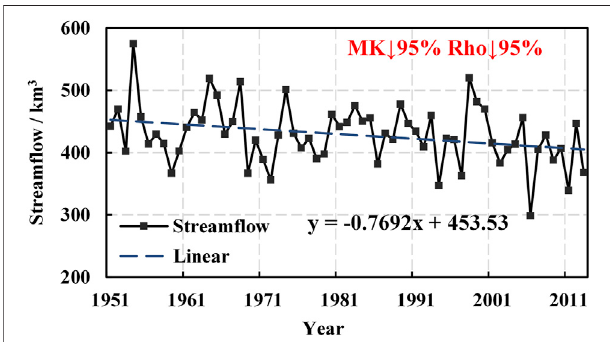
FIGURE3| Annualstream fl owseriesobservedinYichangstation(Note: ↓ represents decreasing trend; 95% represents a con fi dence level of 95%).